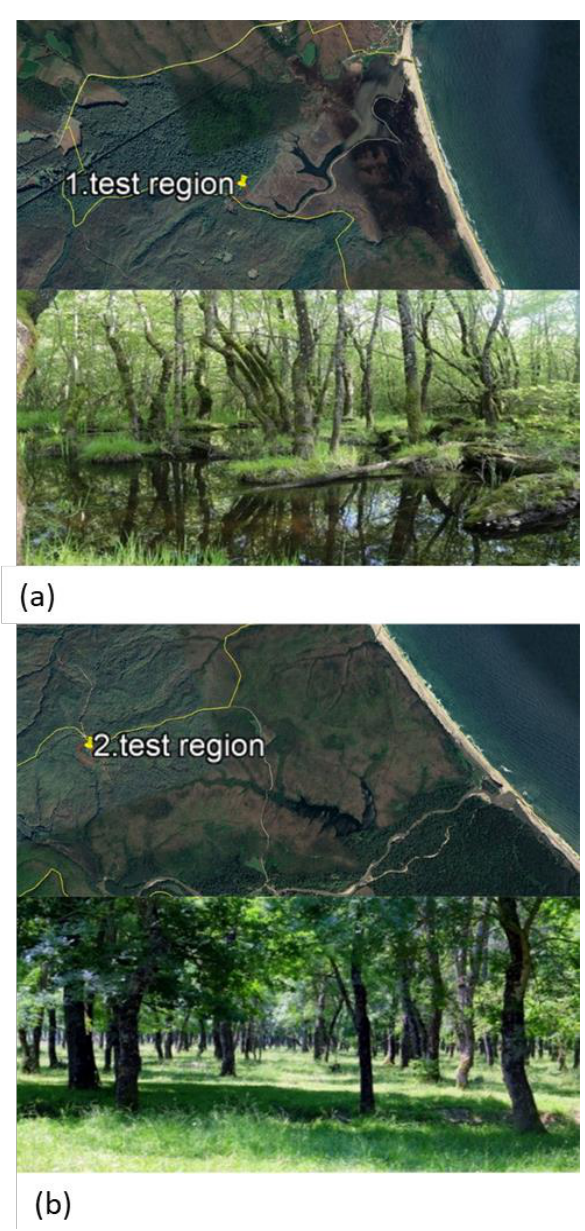
Figure 3. Location of 2 test regions and field photos. (a) Floodplain forest. (b) Mixed